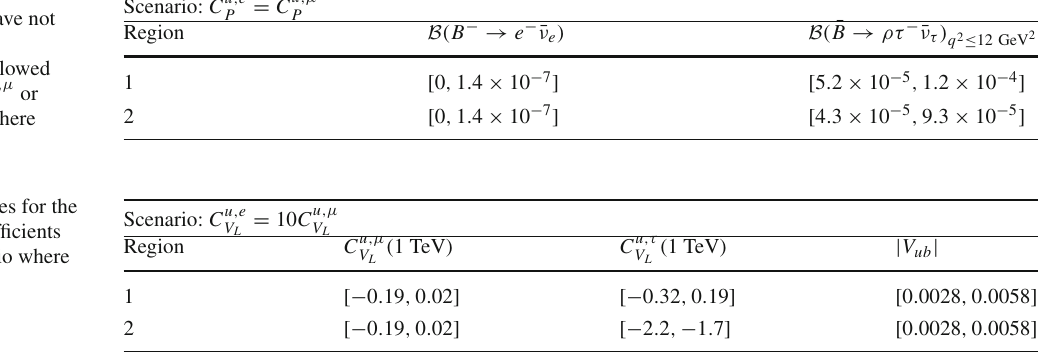
branching ratios that have not yet been measured corresponding to the allowed ranges of | V ub | and C u